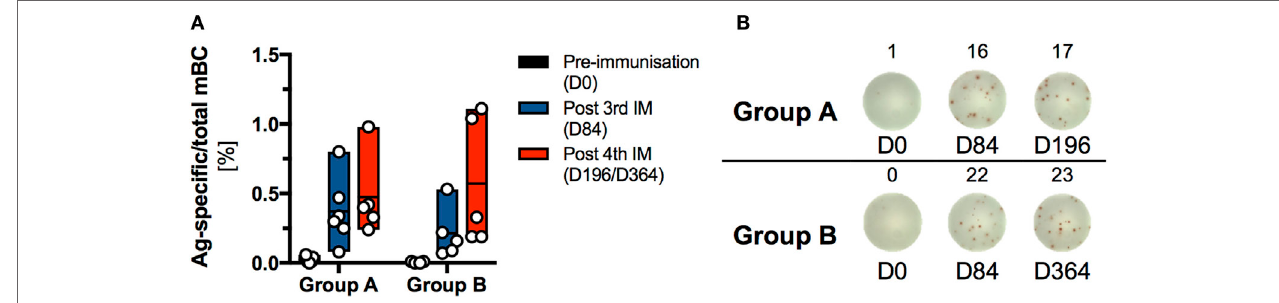
FiGUre 7 | analysis of the memory B cell (mBC) response induced by sequential immunization with the human immunodeficiency virus-antigen Cn54gp140 . Frozen peripheral blood mononuclear cells (PBMCs) were thawed and expanded using human IL-2 and R848 for 4 days. Expanded cells were assayed for antigen (Ag)-specific and total IgG-secreting ASCs by ELISPOT assay at 0, 84, and 196 or 364 days, respectively. Each sample was measured in triplicate, averaged and plotted as Ag-specific per total mBC. (a) Percentage of Ag-specific mBC per total IgG-secreting mBC. Due to the limitation in availability of PBMC at least one data point is missing for the following participants: S001 (D0), S002 (D0), and S013 (D0 and D196). (B) Ag-specific spot forming units/well (indicated by lower indices) Ag-specific mBC and total-IgG-secreting mBC for one selected donor from each group for days 0, 84, and 196 or 364,